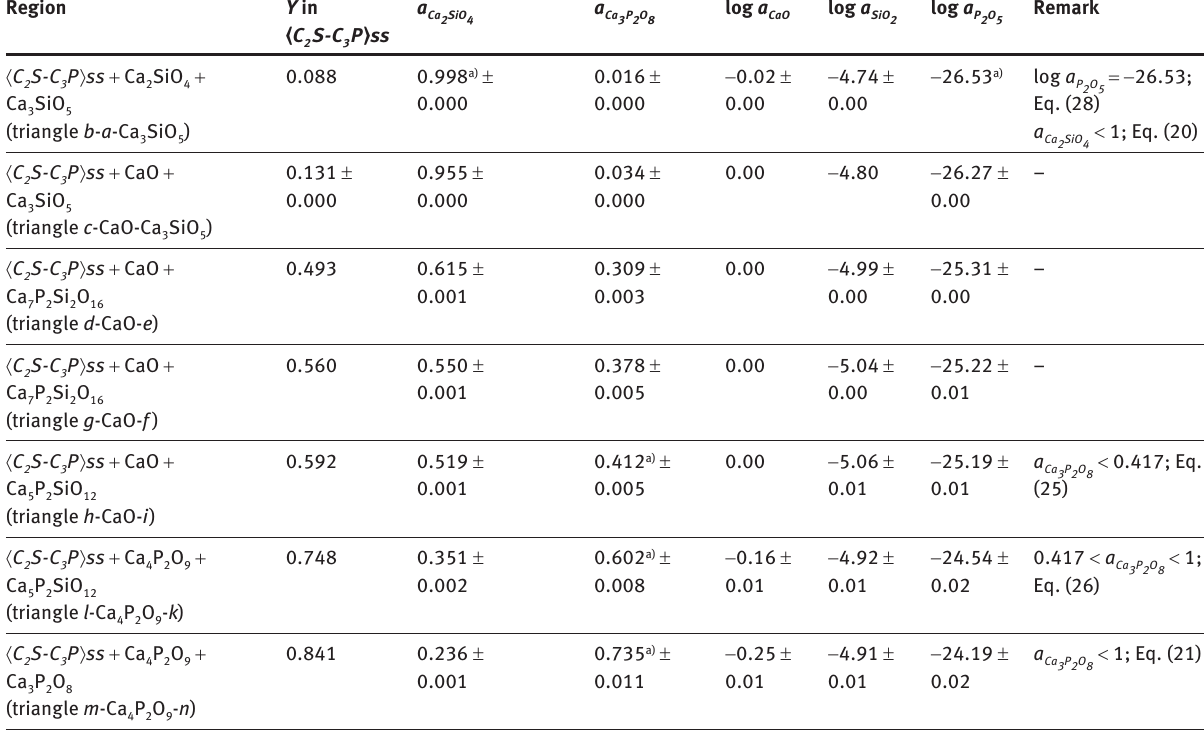
Table 2: Calculation results of the regular solution model with D H ° t (Ca 3 P 2 O 8 ) = 2.10 ± 2.10 kJ ⋅ mol − 1 and W = 5.74 ± 0.12 kJ ⋅ mol − 1